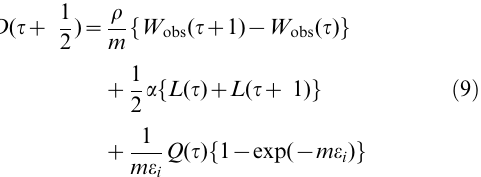
Table 3. Effect of leptin and dieting with respect to the mean drive outside the dietary